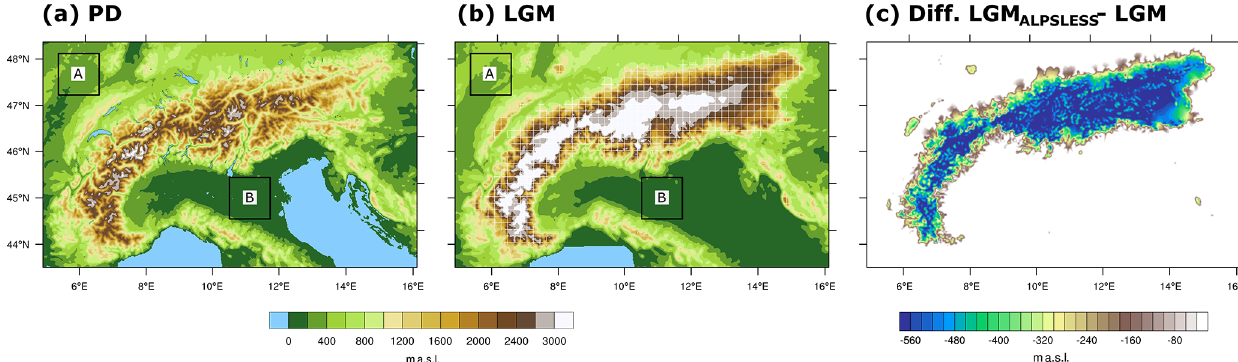
Figure 2. Innermost domain and topography used by WRF. Panel (a) represents the domain at 2km horizontal resolution and the shading indicates PD topography, (b) as panel (a) but for the LGM topography, crosshatched areas are covered by glaciers. Panel (c) shows the difference between LGM ALPSLESS and LGM topography. The boxes in (a) and (b) are the two regions used for the Skew–T diagrams: Site A represents the north-western and site B the central-southern